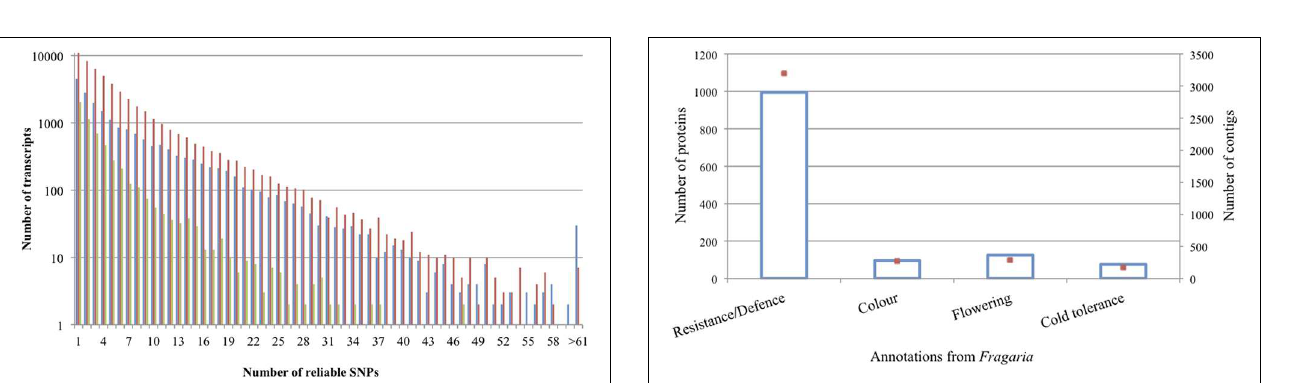
FIGURE 2 | Distribution of reliable SNPs per transcript of K5 (blue bars), GR (red bars), and Rh88 (green bars).